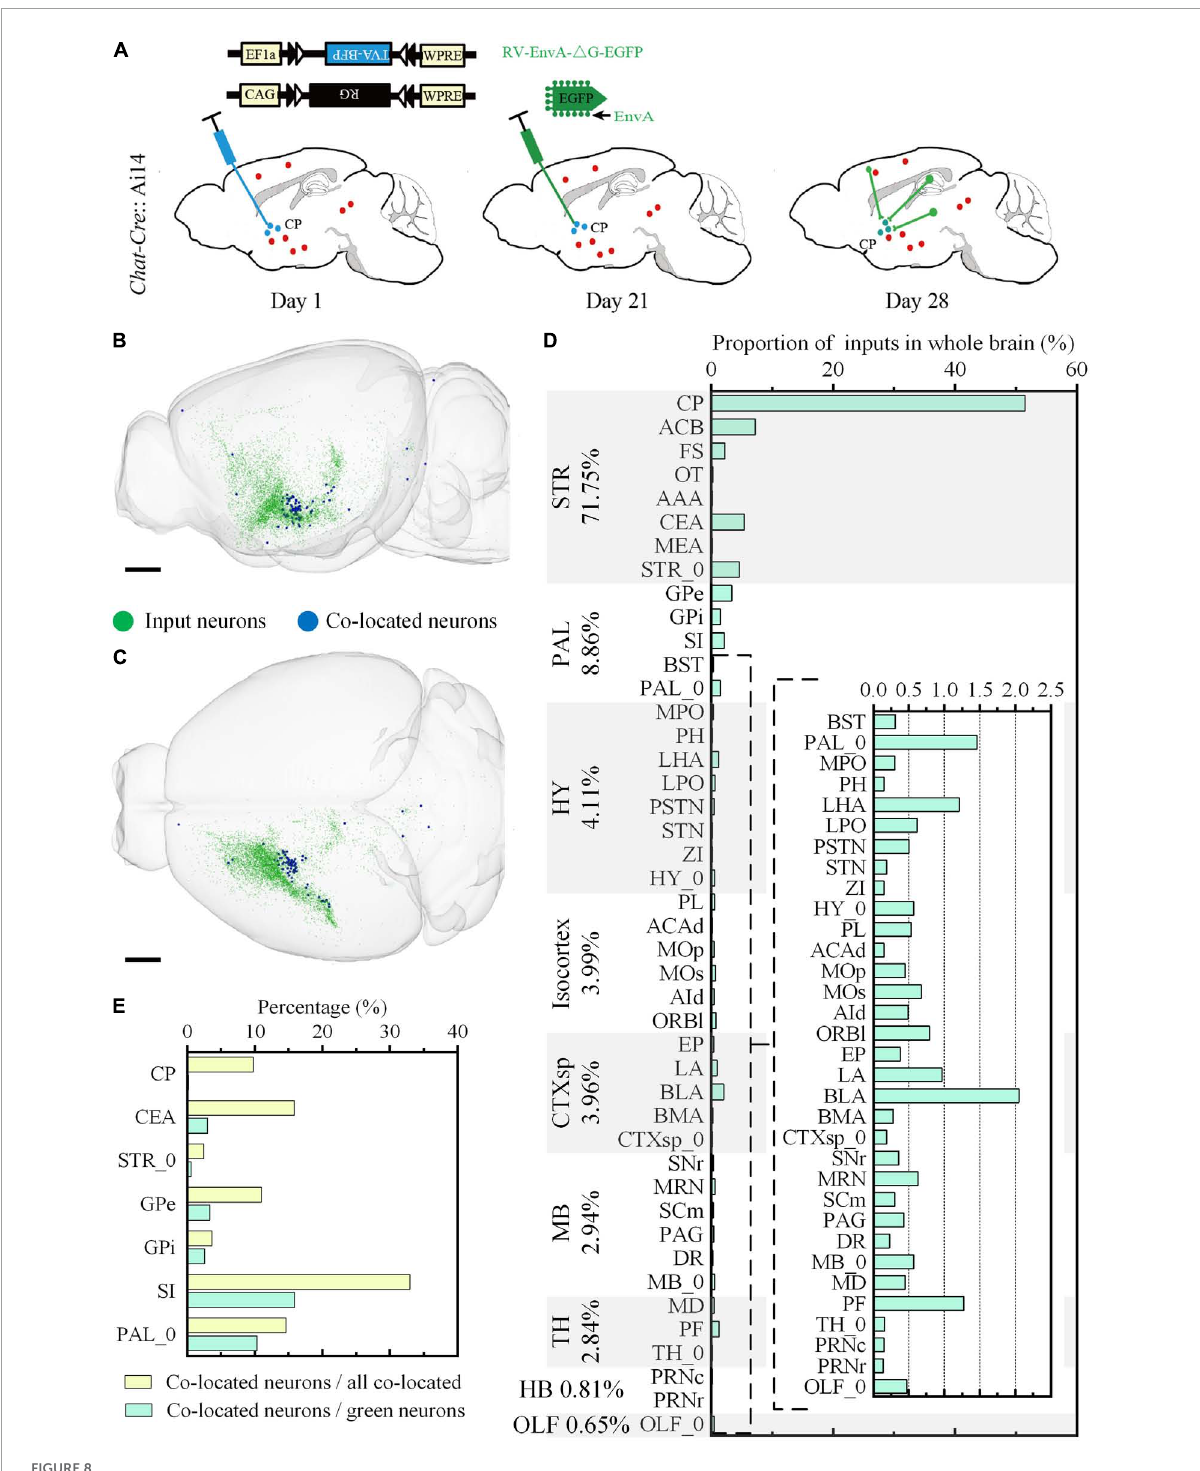
FIGURE8 Whole-brain quantitative statistics of the inputs of the cholinergic neurons in the ventral CP. (A) Labeling schematic of the inputs of the cholinergic neurons in the ventral CP. (B,C) Whole-brain distribution of the input neurons and co-located neurons in sagittal view (B) and horizontal view (C) . (D) The proportion of the inputs in typical brain sub-regions. The percentage to the left of the image indicated the proportion of the inputs in typical brain regions. (E) The yellow histogram represented the proportion of the co-located neurons in brain sub-regions, and the green histogram represented the proportion of the co-located neurons to the inputs of the cholinergic neurons in the ventral CP. Scale bars: (B,C) 1